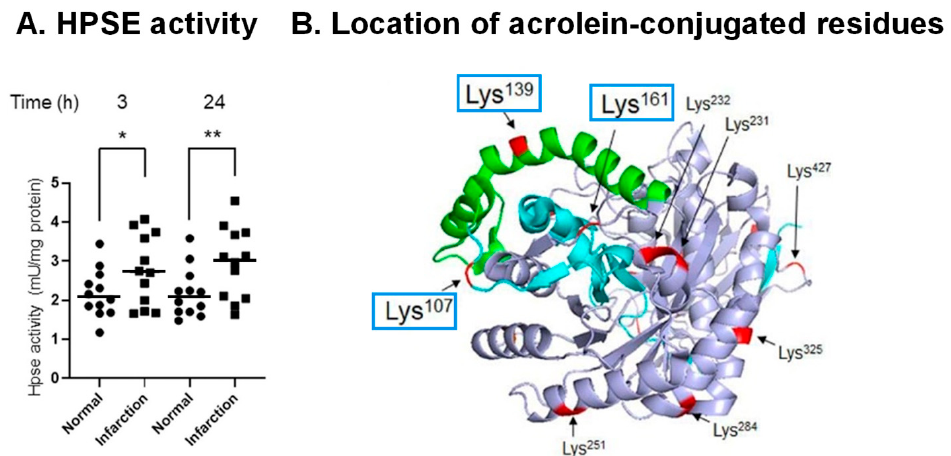
Figure 5. Acrolein-conjugated amino acids in proHPSE involved in the activation of HPSE. ( A ). Elevation of HPSE activity in infarct area compared to normal region at 3 and 24 h after onset of infarction in PIT model mice. *, p < 0.05; **, p < 0.01. ( B ). Location of acrolein-conjugated amino acid residues on proHPSE (PDB ID: 5LA4). Cyan, 8 kDa subunit; green, 6 kDa linker; light blue, 50 kDa subunit. Adapted from Ref. [49].